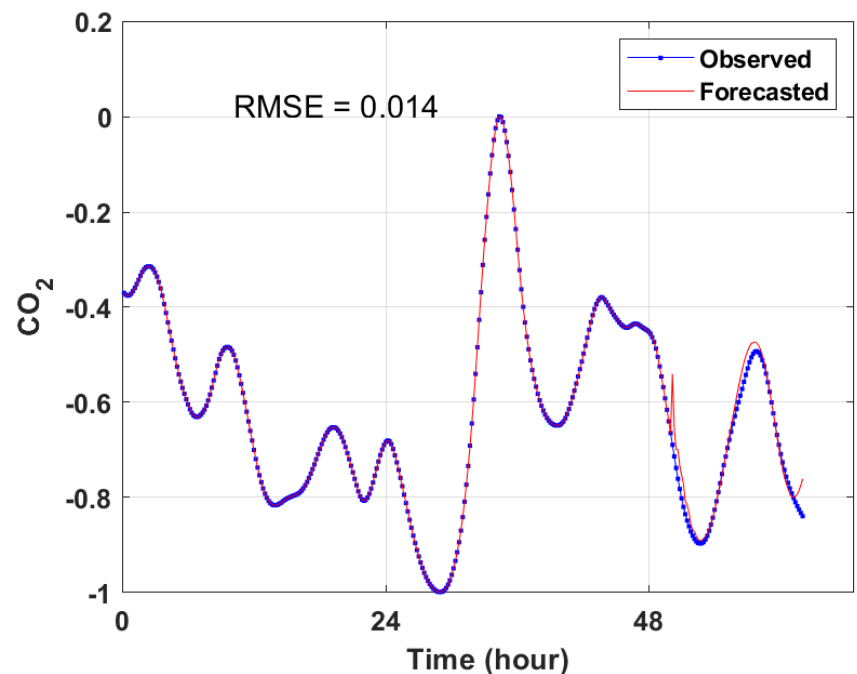
Figure 10. CO 2 forecasting by